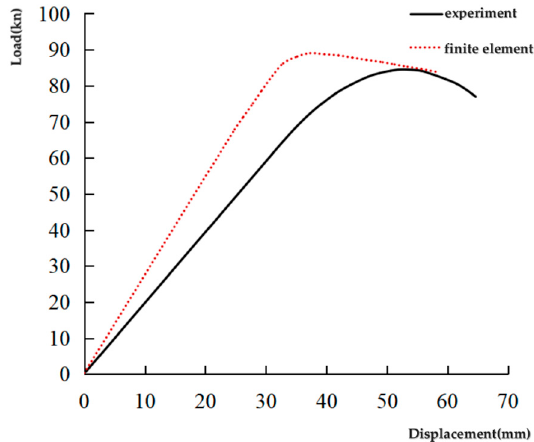
Figure 5. Comparison of jd-2 load-displacement curves.